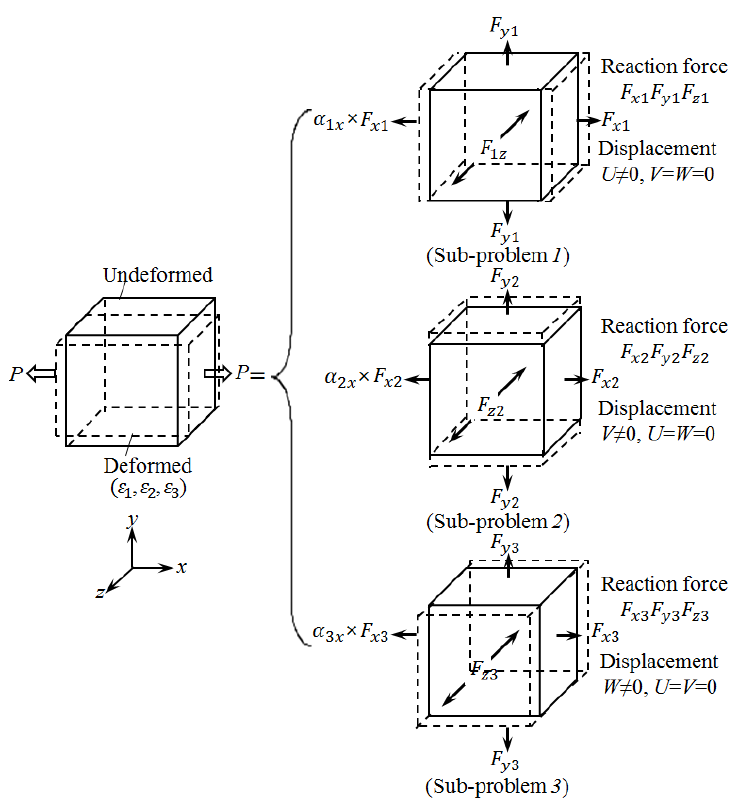
Figure 3 . Schematic representation of the superposition method. Figure 3. Schematic representation of the superposition